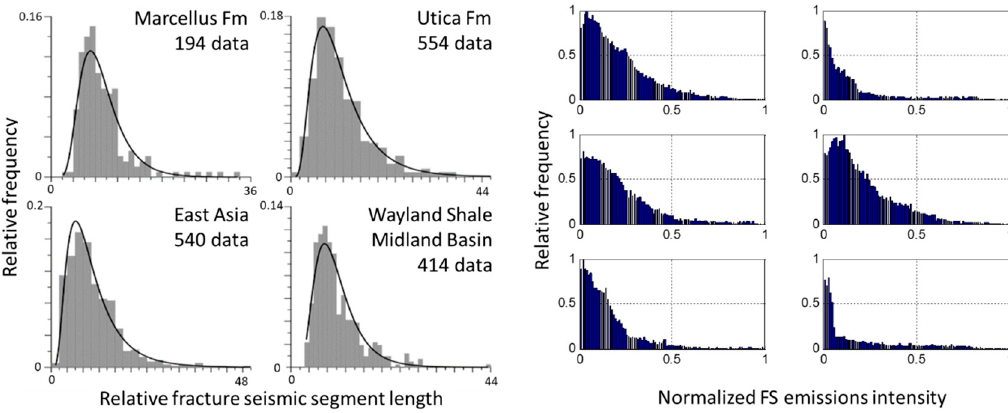
Figure 8. ( Left ) Normalized length distributions of linear fracture seismic intensity segments from four different reservoirs: (Clockwise) Marcellus, Utica, East Asia, Wayland. Linear backbone segments can be seen in the fracture seismic map slice in the bottom image in Figure 1. ( Right ) Normalized histograms of seismic fracture emission intensity recorded shale reservoir fracks, above. Data are from Lacazette et al. (2013) [29].